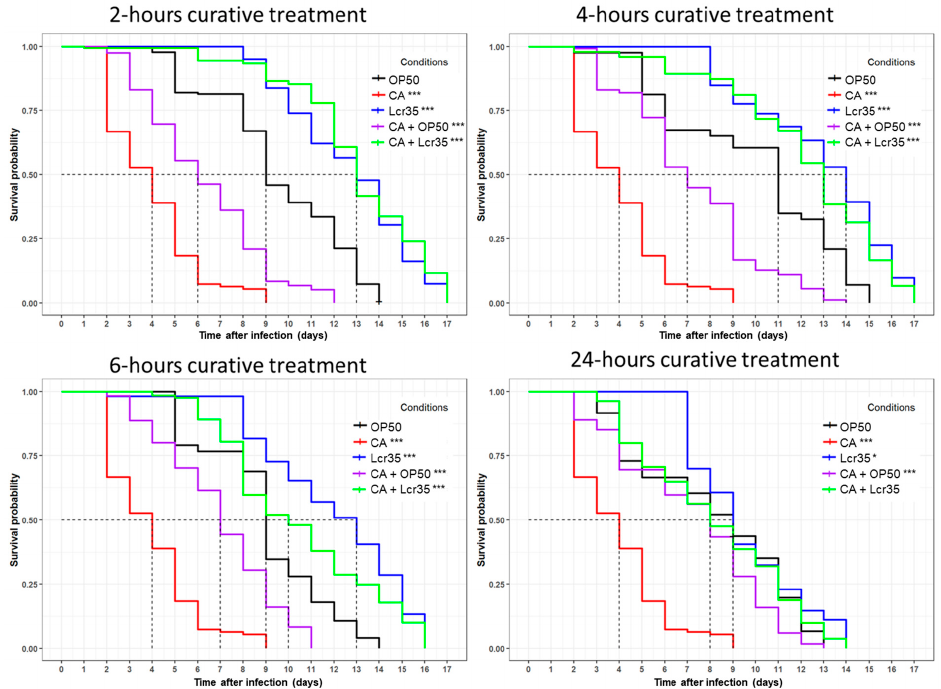
Figure 3. Curative effects of Lcr35 ® against C. albicans ATCC 10231. Mean survival, where half of the population is dead, is represented on the abscissa. The asterisks indicate the p -values (log-rank test) against OP50 ( p < 0.05: *; p < 0.001: ***). Infection duration: 2 h; 2-h curative treatment ( E. coli